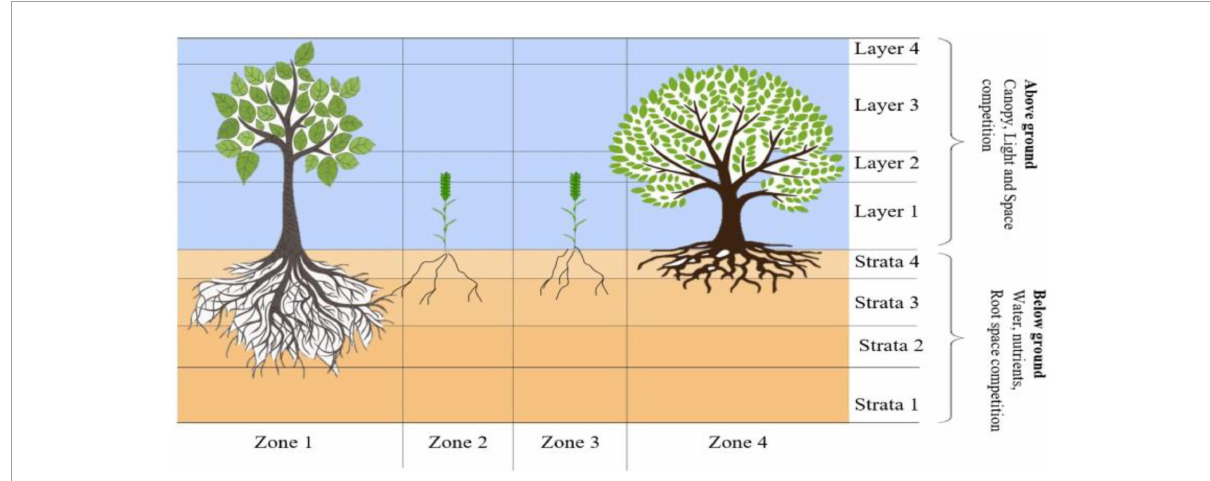
FIGURE3 Sketch of the spatial hypothetical distribution of soil, water, and light in different zones, strata, and layers and the competition that exists between trees and crops in agroforestry systems and a simple and complex model of AF.